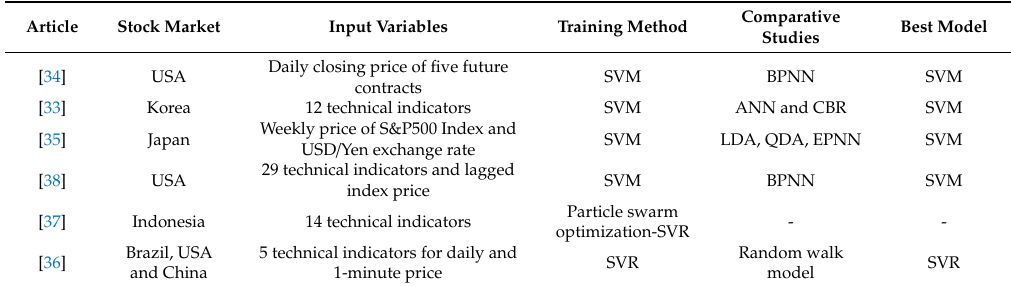
Table 2. Summary of support vector machine (SVM) based prediction methods used by this study’s